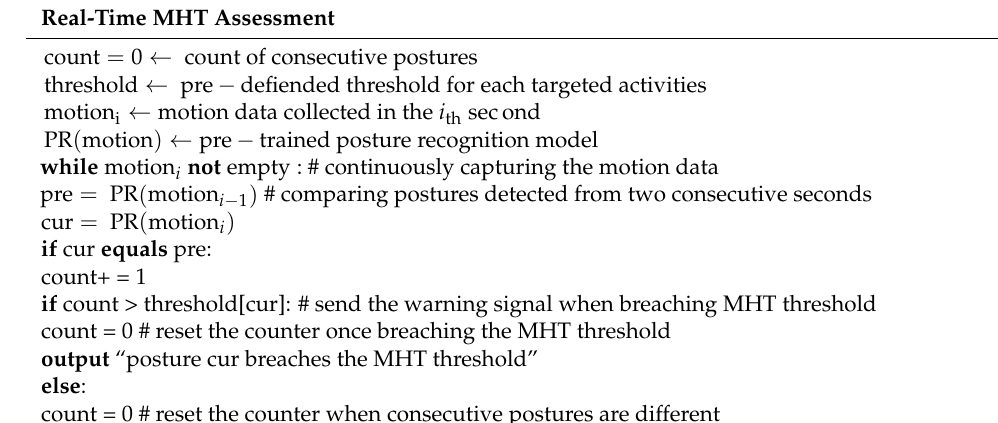
Table A2. Pseudo-code for real-time MHT Assessment.